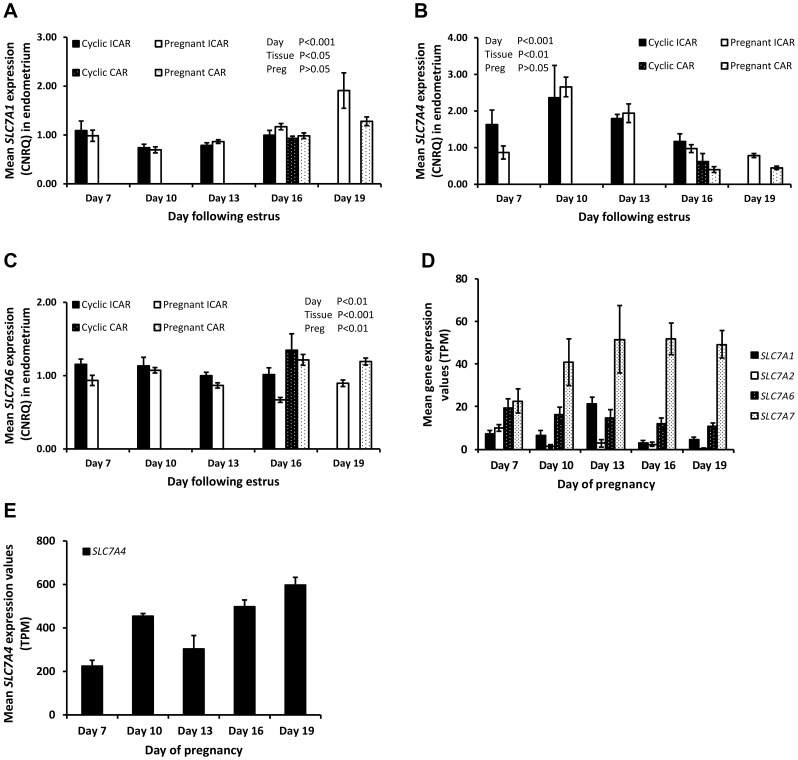
Gene expression values in the endometrium for cationic amino acid transporters as determined by qRT-PCR analysis.Data are displayed as mean calibrated, normalized, relative expression values in arbitrary units (CNRQ ± SEM) in the intercaruncular region of the endometrium from cyclic (solid bars) and pregnant (open bars) heifers and caruncular regions of cyclic (black bars white stipple) and pregnant heifers (while bars black stipple) (n = 5 per treatment per time-point). (A) SLC7A1 CNRQ expression with a significant effect of day and tissue type (B) SLC7A4 expression was significantly affected by day and tissue type and (C) SLC7A6 whose expression was significantly affected by day, tissue type and pregnancy status. Significance was set at P<0.05. (D&E) Gene expression values for cationic amino acid transporters in the bovine conceptus during distinct developmental stages. Values were determined by RNA sequencing and are given as mean transcripts per million (TPM ± SEM) with n = 5 per time-point. A significant effect of stage of conceptus development was observed for all genes (P<0.05).